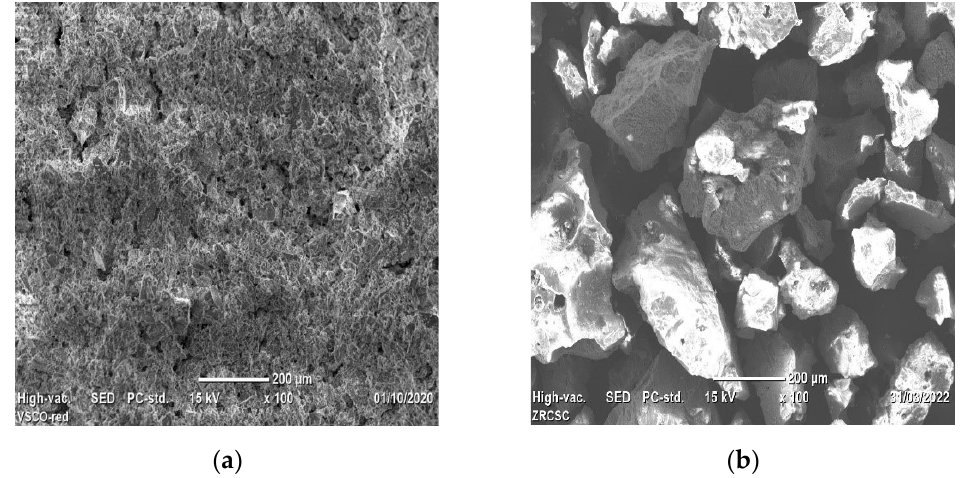
Figure 3. SEM image of ( a ) VSco and ( b ) ZrOCSc before adsorption experiments.